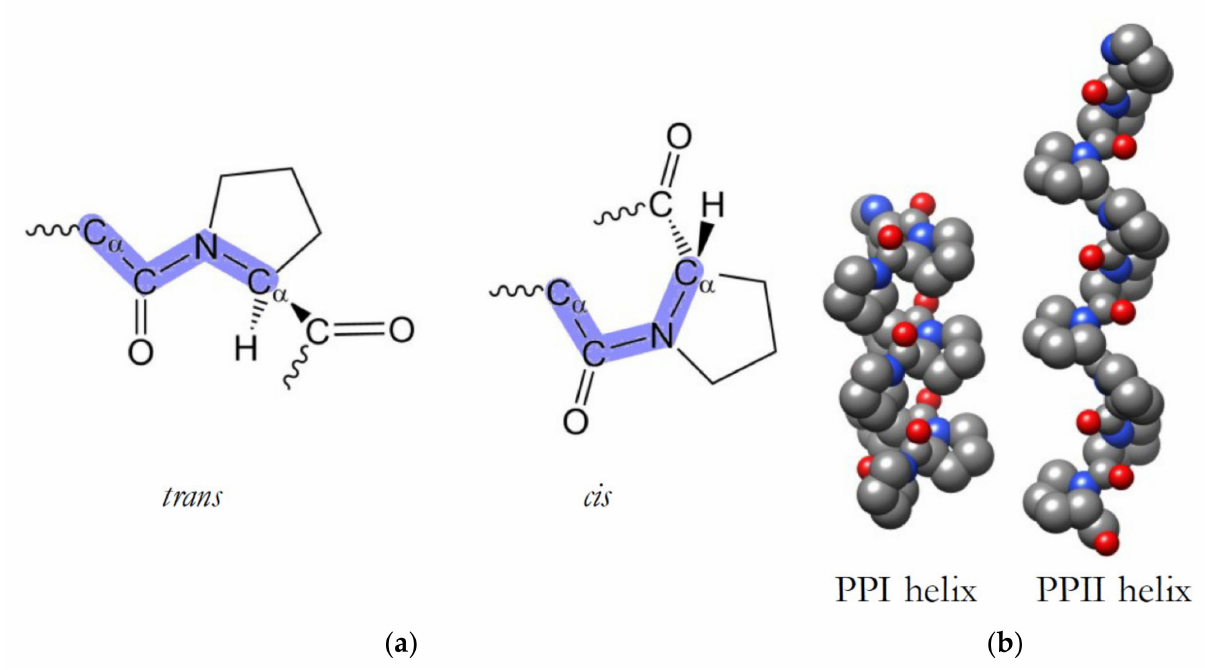
Figure 1. x-proline bond isomers and polyproline type I and type II helices. ( a ) trans and cis isomers of x-Pro peptide bonds, where x is any residue preceding the proline. The bonds defining the geometries are highlighted in blue. ( b ) Side views of PPI and PPII helices, comprised of nine proline residues. The helices are oriented such that the top represents the N-terminus. The figure was generated using USCF Chimera [129]. Carbon atoms are shown in grey, nitrogen in blue and oxygen in red. Hydrogen atoms are omitted for